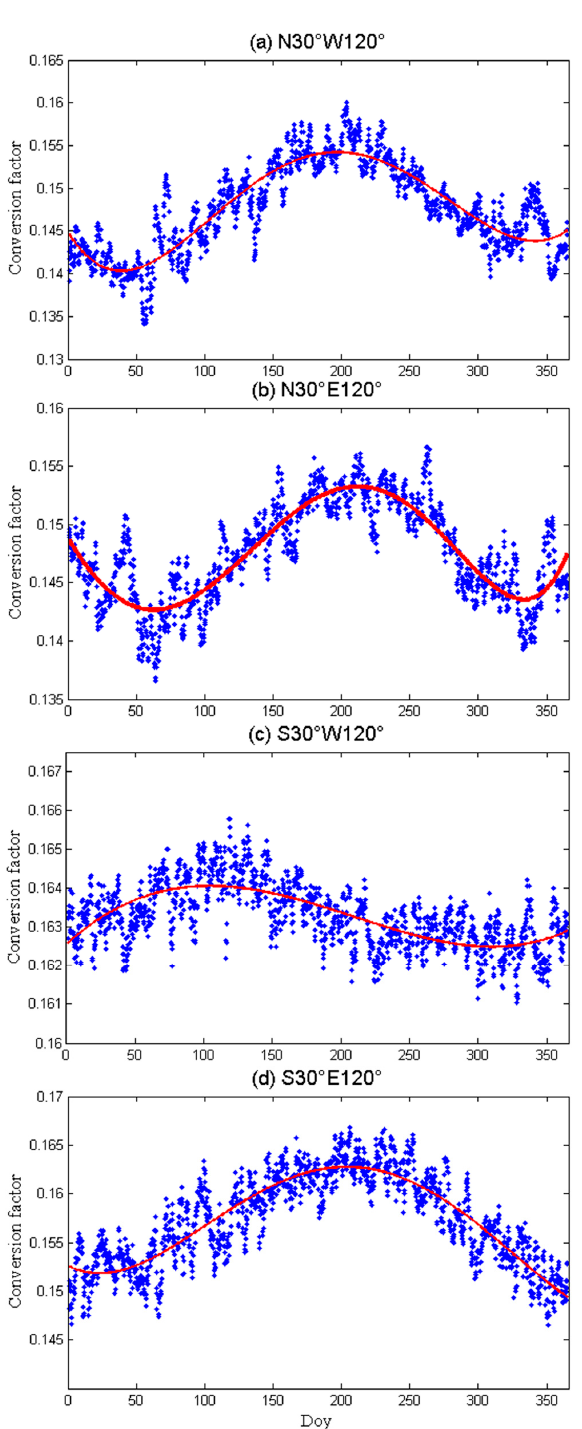
Figure 2. Relationship between the conversion factor and the semiannual change at the four selected the year 2013. 3. Relationship between the conversion factor and the